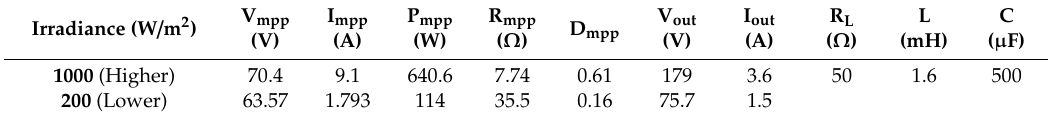
Table 1. PV array and boost converter characteristics under the lower and higher solar irradiances.